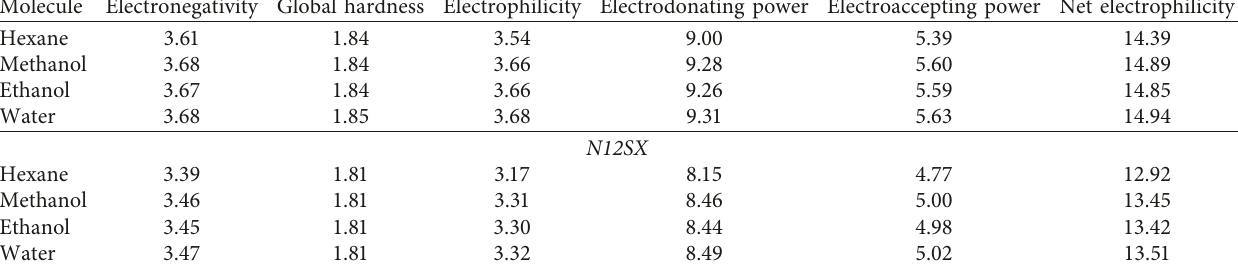
Table 8: Global reactivity descriptors (in eV) for the fucoxanthin pigment calculated with the MN12SX and N12SX density functionals and the Def2TZVP basis set using the four solvents, simulated with the SMD parametrization of the IEF-PCM model.